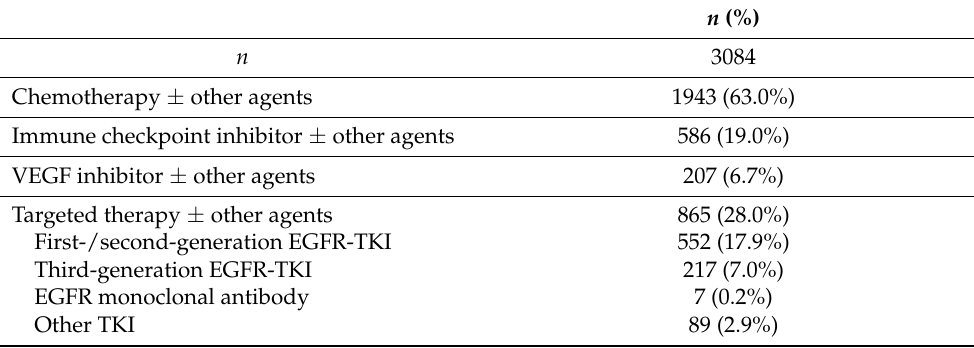
Table 2. First-line